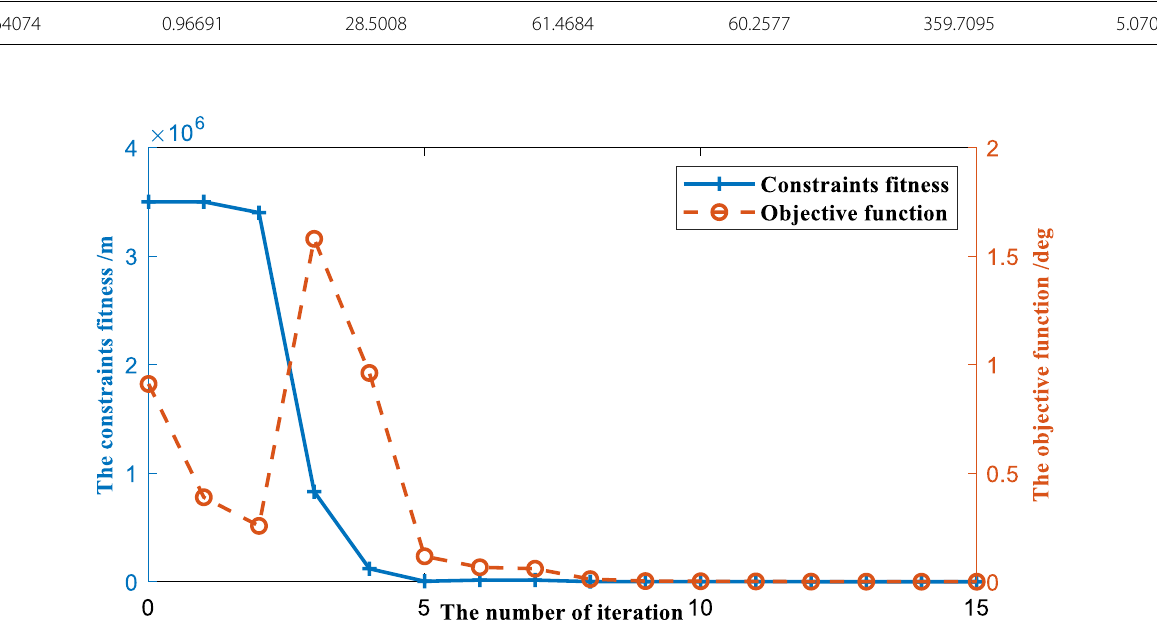
Table 6 The Earth‑centered modified classical orbital elements computed with the high‑precision model at TLI epoch κ EJ2 /m e EJ2